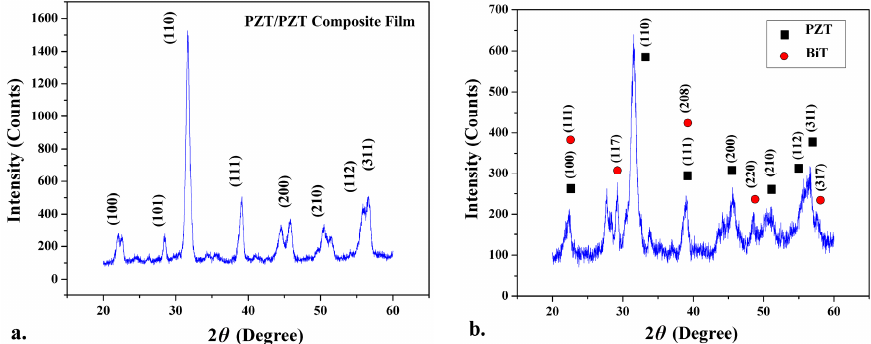
Figure 6. X-ray diffraction (XRD) patterns for ( a ) PZT/PZT and ( b ) PZT/BiT thick composite films.